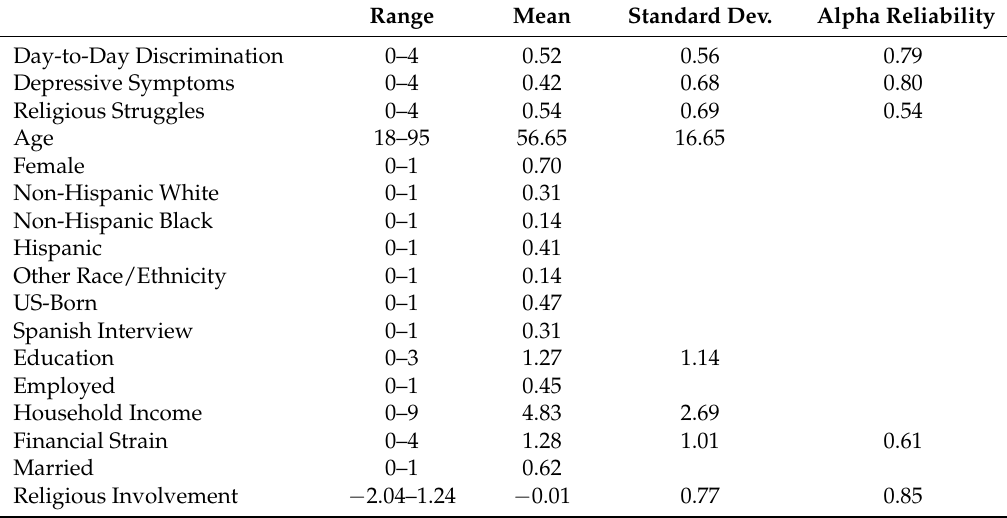
Table 2. Descriptive Statistics ( n = 444).